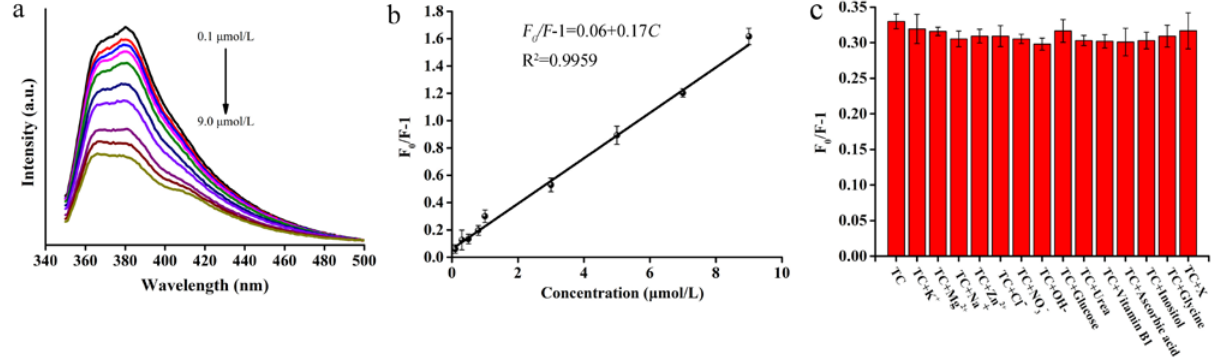
Figure 7. ( a ) Fluorescence spectra of the AdaPOF dichloromethane suspension after adding TC–methanol solution of different concentrations ( λ ex = 334 nm); ( b ) The liner calibration curve for the determination of TC concentration; ( c ) The influence of coexisting ions or compounds on the determination of TC by AdaPOF (X = K + , Mg 2+ , Na + , Zn 2+ , Cl − , NO 3 − , OH − , glucose, urea, vitamin B1, ascorbic acid, inositol and glycine). ( λ ex = 334 nm, c = 1.0 µ mol/L).